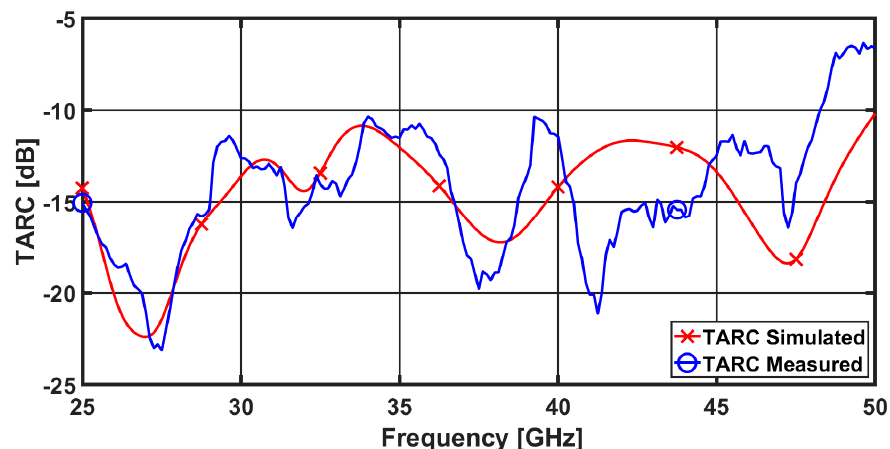
Figure 11. TARC simulated and measured results of the proposed four-element MIMO antenna.